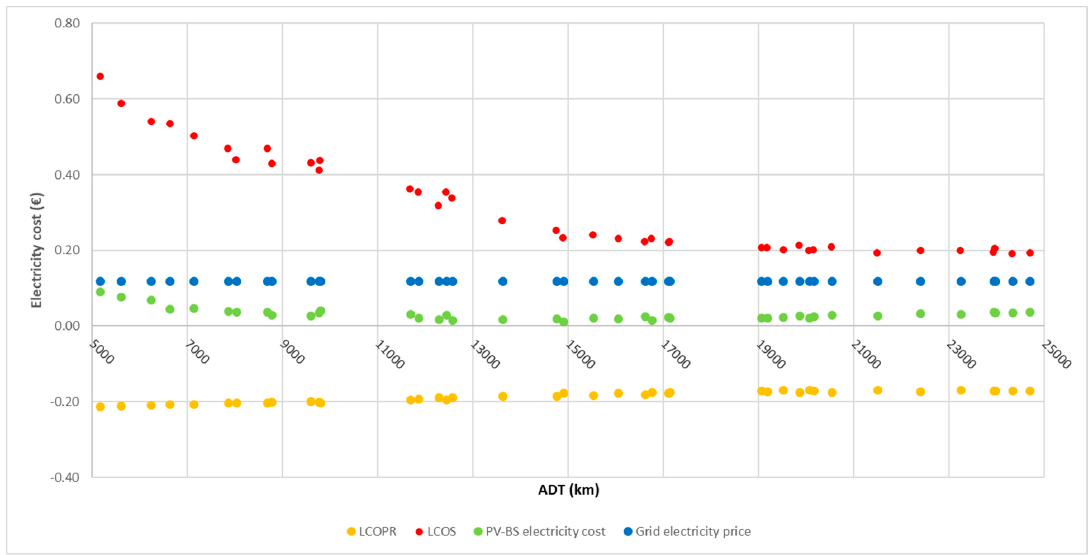
Figure 6. Energy source used to charge the EV and electricity discharged into the electrical grid with varying ADT in Scenario 1.